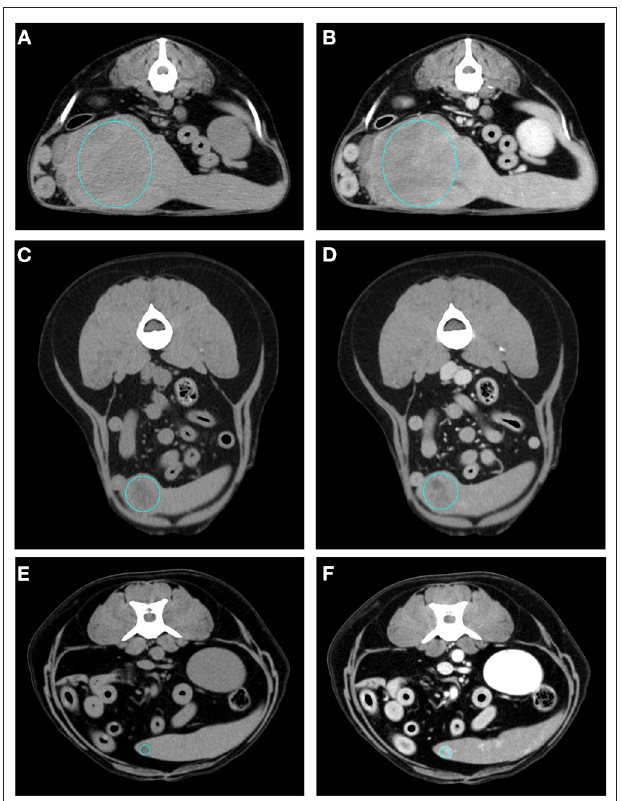
FIGURE 1 | Pre- (A) and post- (B) contrast images of NH showing isoattenuation and hypoenhancement, diffuse enhancement pattern with heterogeneous distribution, well-defined margins, irregular surface, and a cyst-like appearance. Pre- (C) and post- (D) contrast images of NH showing hypoattenuation and hypoenhancement, diffuse enhancement pattern, with heterogeneous distribution, ill-defined margins, regular surface, and cyst-like appearance. Pre- (E) and post- (F) contrast images of NH showing hypoattenuation and hyperenhancement, rim enhancement pattern with heterogeneous distribution, well-defined margins, irregular surface, and solid appearance. The ROI is placed inside the lesions.